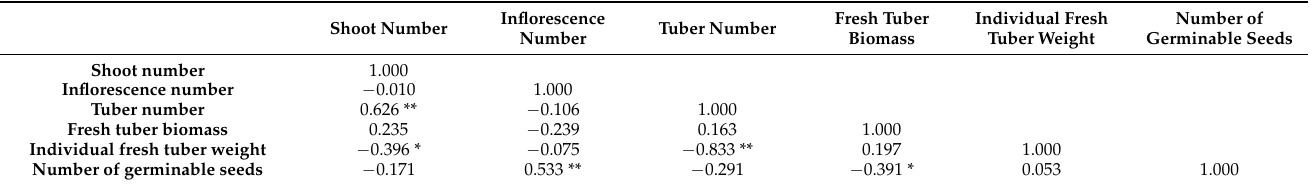
Table 5. Pearson’s correlation coefficients between the morphological variables measured in 2019 on 35 C. esculentus clonal